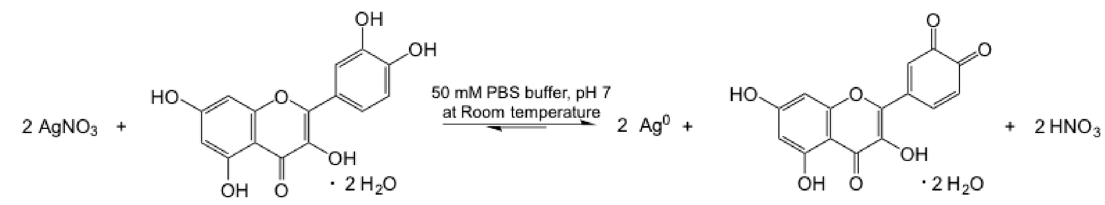
Figure 1. Synthesis of Ag nanoparticles through the reduction of AgNO 3 by quercetin.